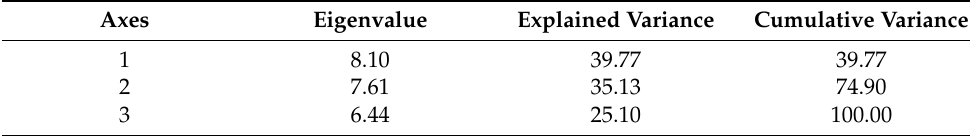
Table 5. THE Impact Rankings explained variance. Axes Eigenvalue Explained Variance Cumulative